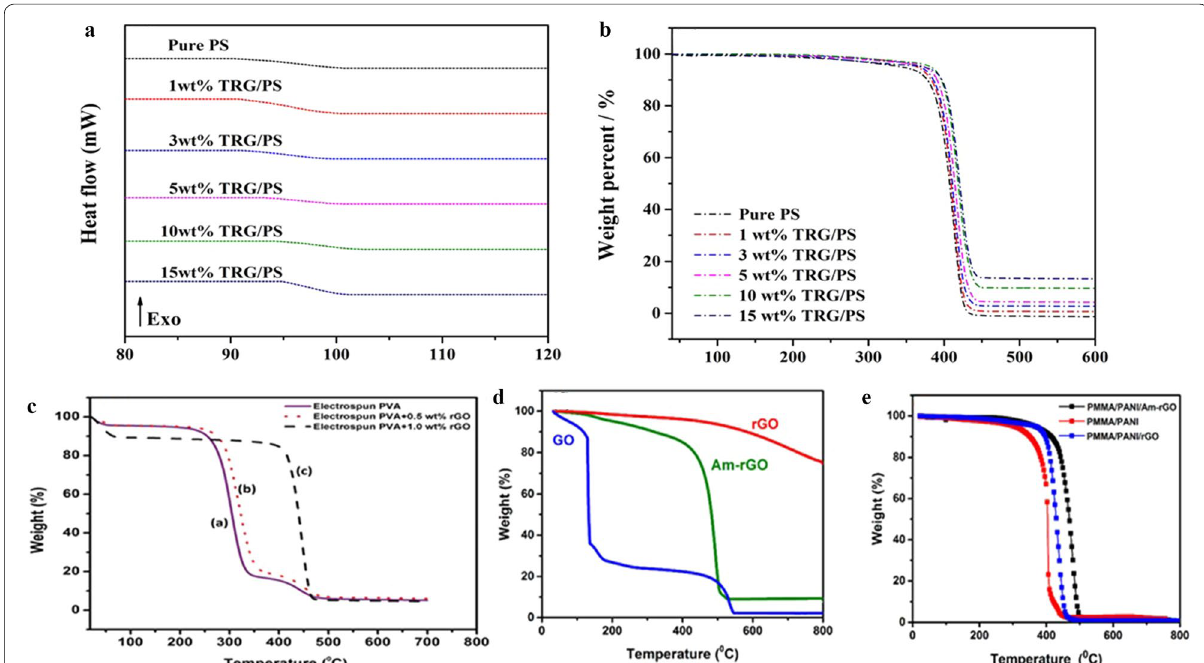
Fig. 4 Dimensionally stable anodes (DSC) ( a ) and thermogravimetric analysis (TGA) ( b ) curves of pure PS matrix and the TRG/PS nanocomposites. Reproduced with permission from [158] Copyright 2018 Elsevier. c TGA curves of electrospun PVA mats mixed with GO. Reproduced with permission from [184] Copyright 2019 American Scientific Publishers. d TGA curves of rGO, rGO and AM‑rGO. e TGA curves electrospun PMMA/PANI/ AM‑rGO, PMMA/PANI/rGO and PMMA/PANI nanofibers. As shown in e , the thermal degradation temperature of PMMA/PANI/Am‑rGO nanofibers increased to ~ 441 °C, a magnitude higher than that of the PMMA/PANI samples at ~ 348 °C. Both d , e are reproduced with permission from